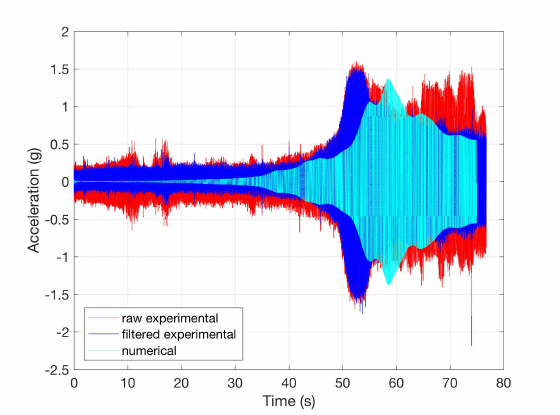
Figure 11. Comparison of raw experimental data (red) against filtered experimental data (blue) and simulated data (light blue): time